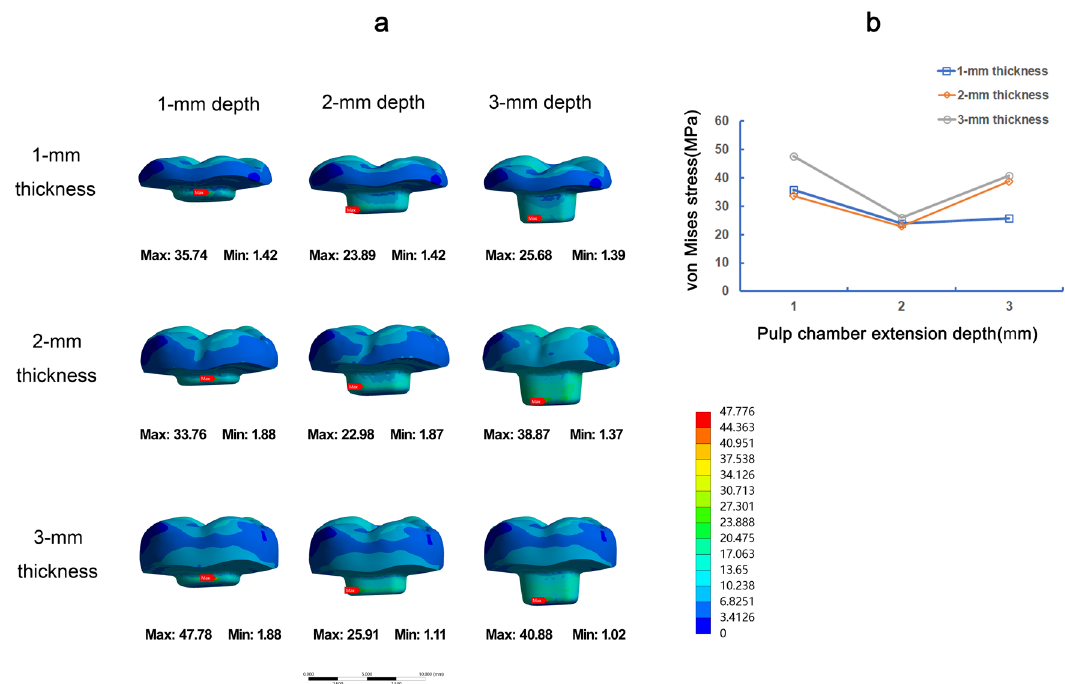
Fig. 6 The von Mises stress (MPa) distribution on endocrown restorations in 9 FEA models under horizontal load. Stress distribution plots of nine endocrown restorations with 1-mm, 2-mm, or 3-mm pulp chamber extension depth in combination with 1-mm, 2-mm, or 3-mm